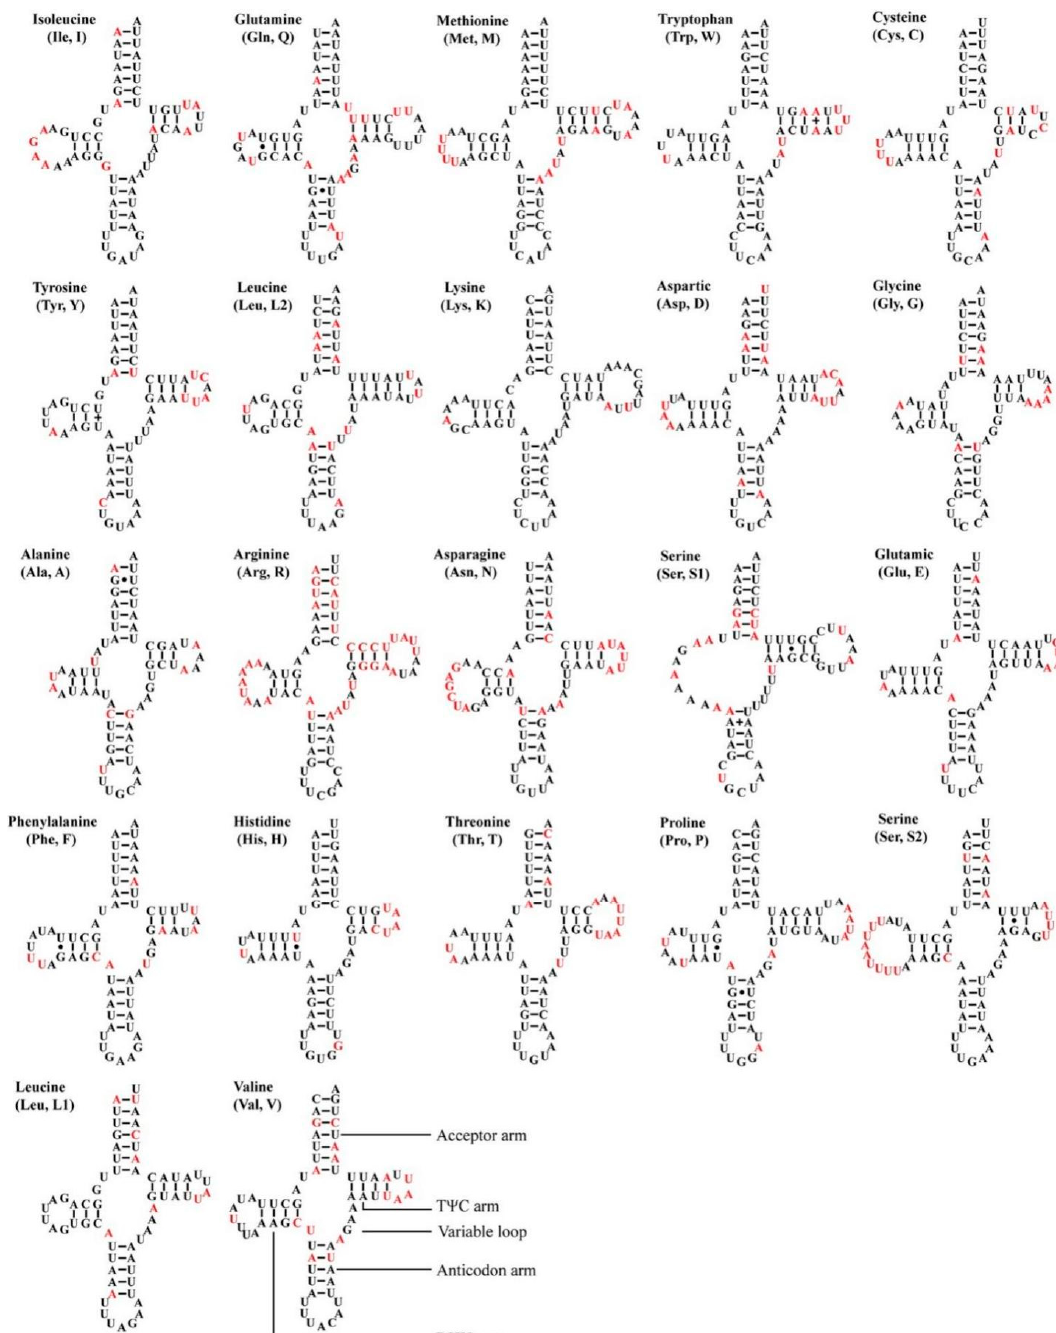
Figure 5. Predicted secondary cloverleaf structures for the tRNAs of the newly sequenced Atkinsoniella species. The tRNA arms are illustrated as for trnV. Dashes (–), solid dots (•), and pluses (+) indicate the Watson–Crick base pairings, G–U bonds, and mismatches, respectively. The conserved and variable sites among the 12 Atkinsoniella species are indicated using black and red, respectively.